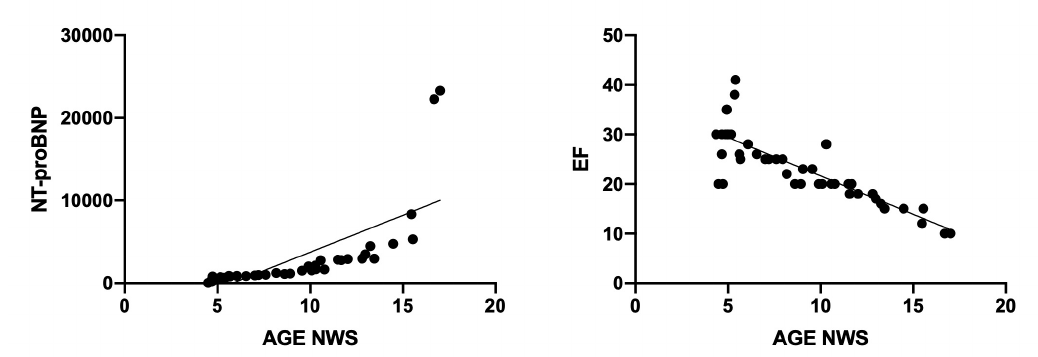
Figure 6. Correlations between salivary AGE content, serum NT-proBNP, and cardiac ejection fraction in patients with heart failure. Abbreviations: AGE—advanced glycation end products; EF—ejection fraction; NT-proBNP—N-terminal fragment of prohormone B-type natriuretic peptide; NWS—non-stimulated whole saliva.